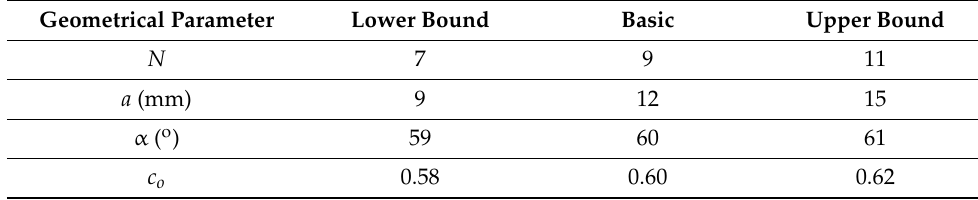
Table 2. Final range of geometrical parameters for the GFA.